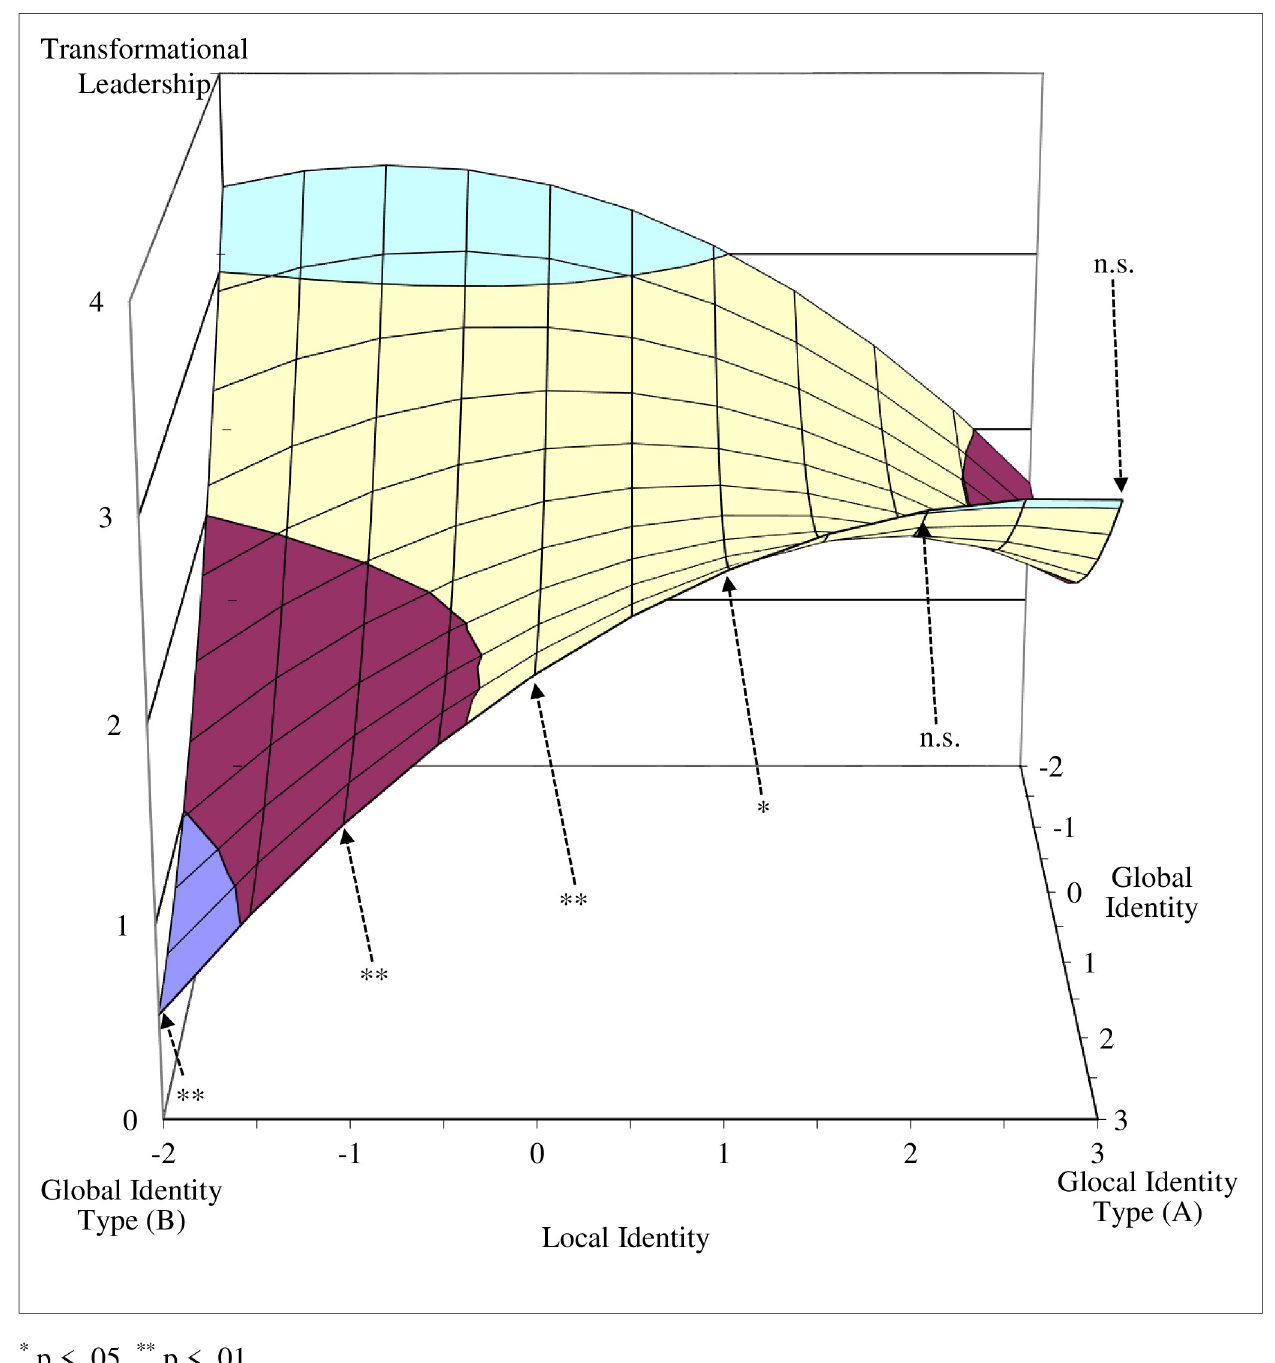
Fig 7. Tangent slope significance along the global–glocal line as predictor of transformational